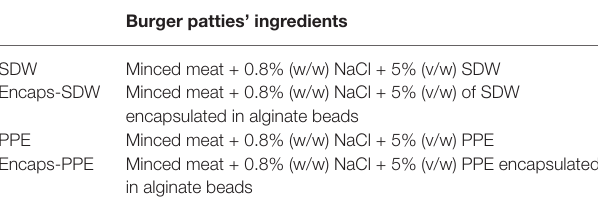
TABLE 1 | Formulations of beef burger patties under